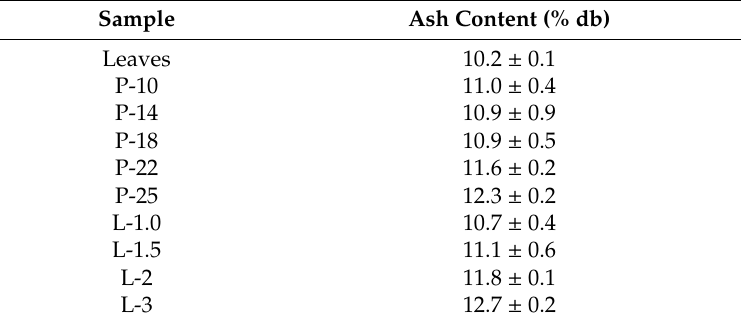
Table 3. Ash content of leaves and pellets.